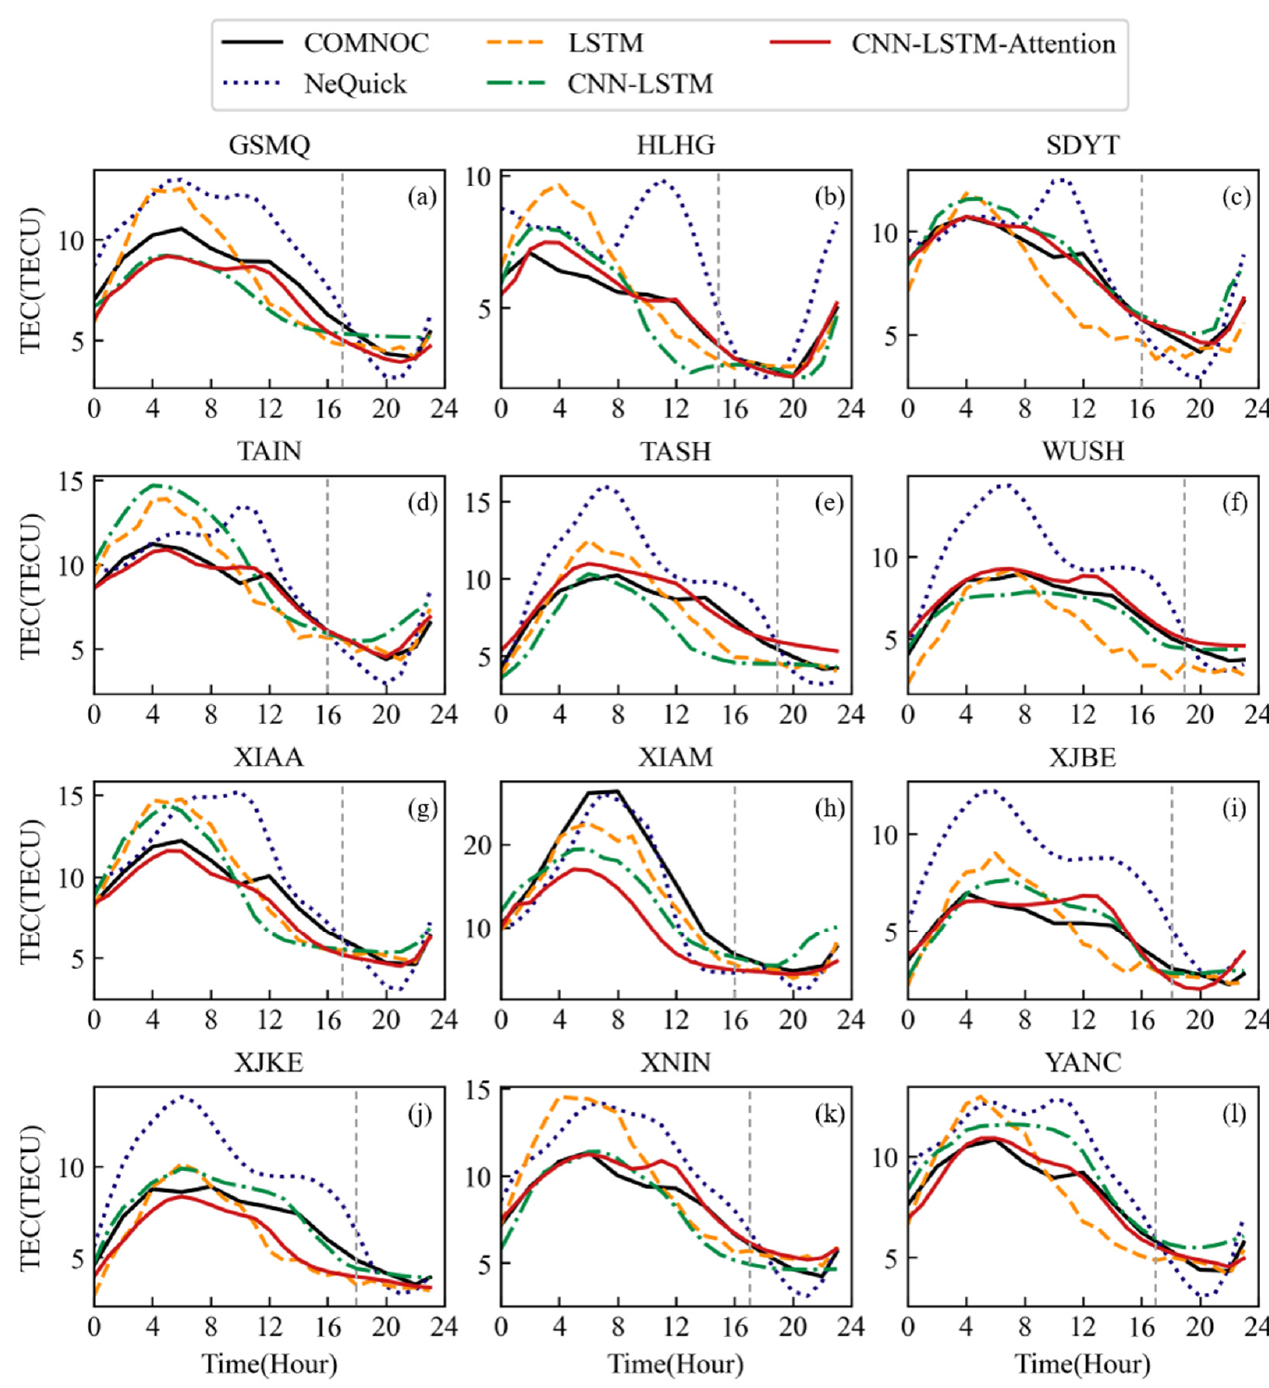
Figure A3. ( a – l ) Comparison of GNSS measured values (black solid line), NeQuick (blue dotted line), LSTM (yellow dotted line), CNN-LSTM (green dotted line), and CNN-LSTM-Attention (red solid line) models forecasted values for other 12 GNSS stations on magnetic quiet days. The gray dotted line indicates midnight LT.